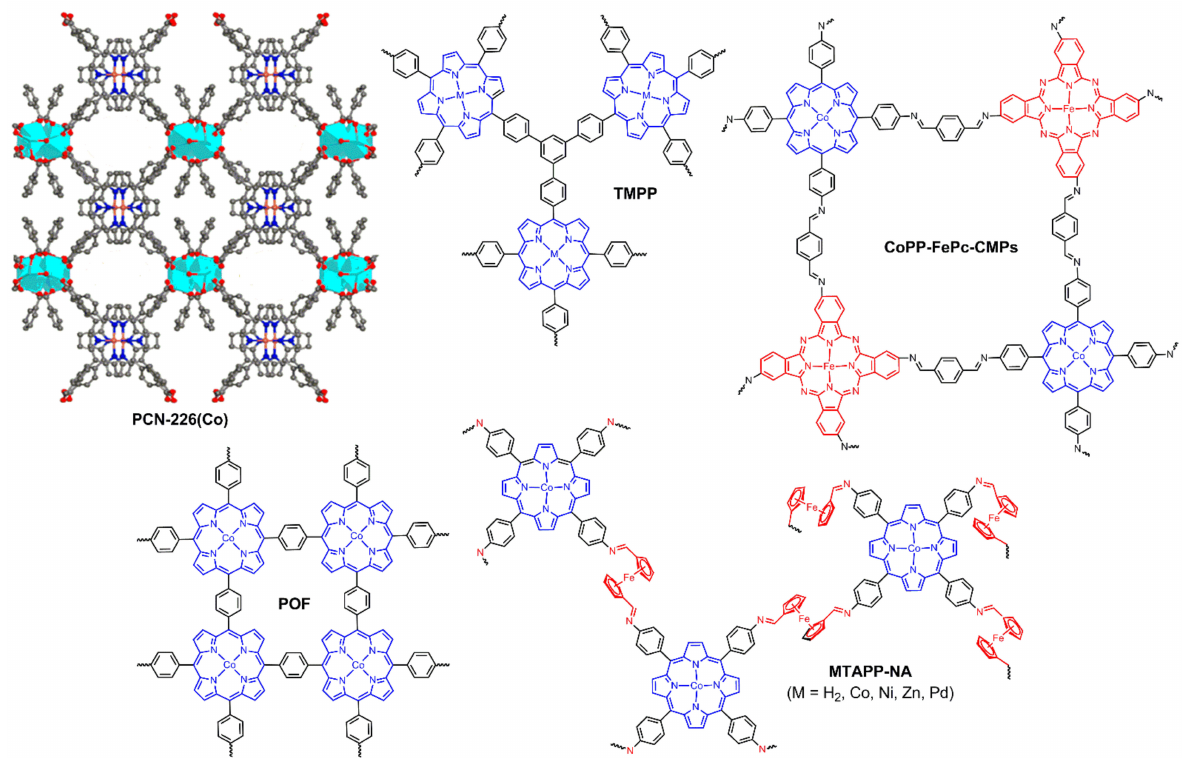
Figure 16. Porphyrin-based porous polymers for bifunctional oxygen electrocatalysis. Reprinted with permission from ref. [101]. Copyright 2020 American Chemical Society. Reproduced from ref. [102,104,105,111].